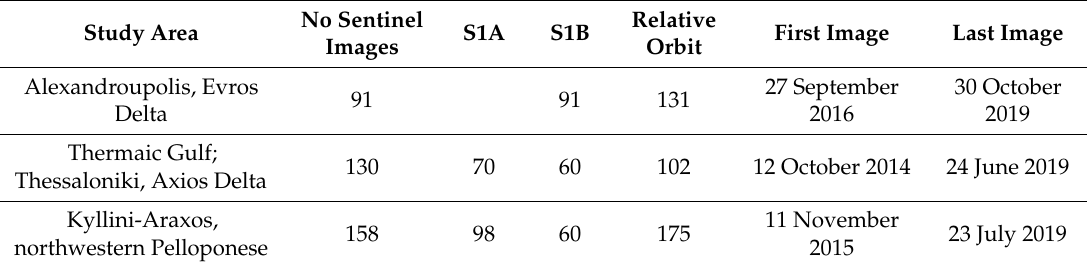
Table 1. Characteristics of the Sentinel-1 synthetic aperture radar acquisitions used in the present study. No Sentinel Relative Study Area S1A S1B First Image Last Image Images Orbit Alexandroupolis, Evros 91 Delta